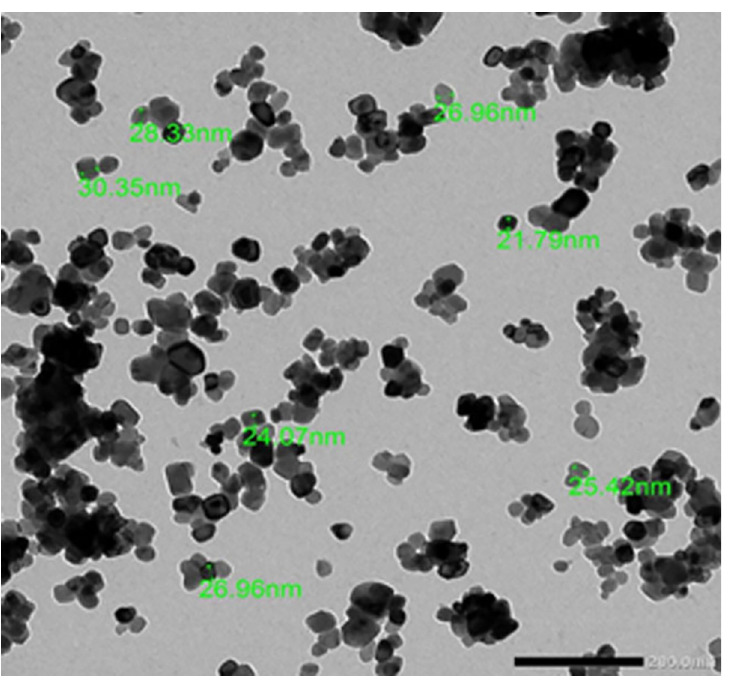
Fig 1. Transmission electron micrograph of NiO-NPs.